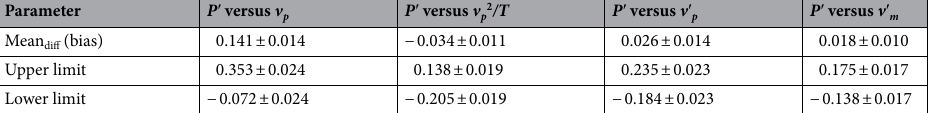
Parameter P ′ versus v p P ′ versus v p 2 /T P ′ versus v ′ p P ′ versus v ′ m